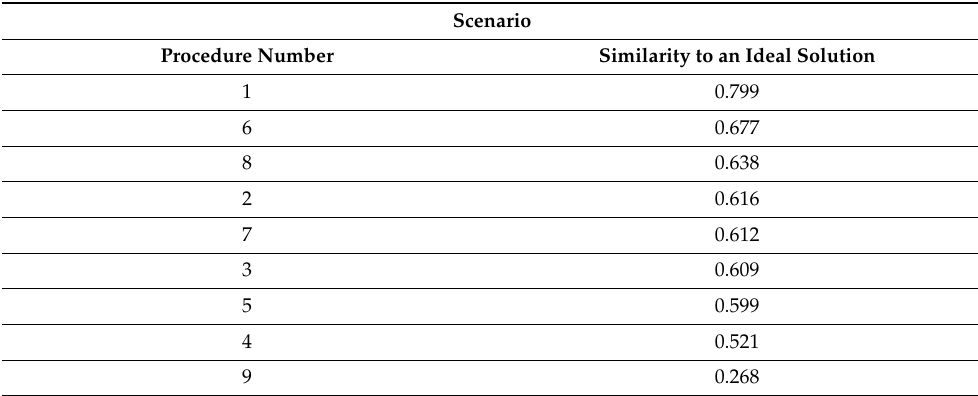
Table 3. Ranking results of analytical procedures according to a given